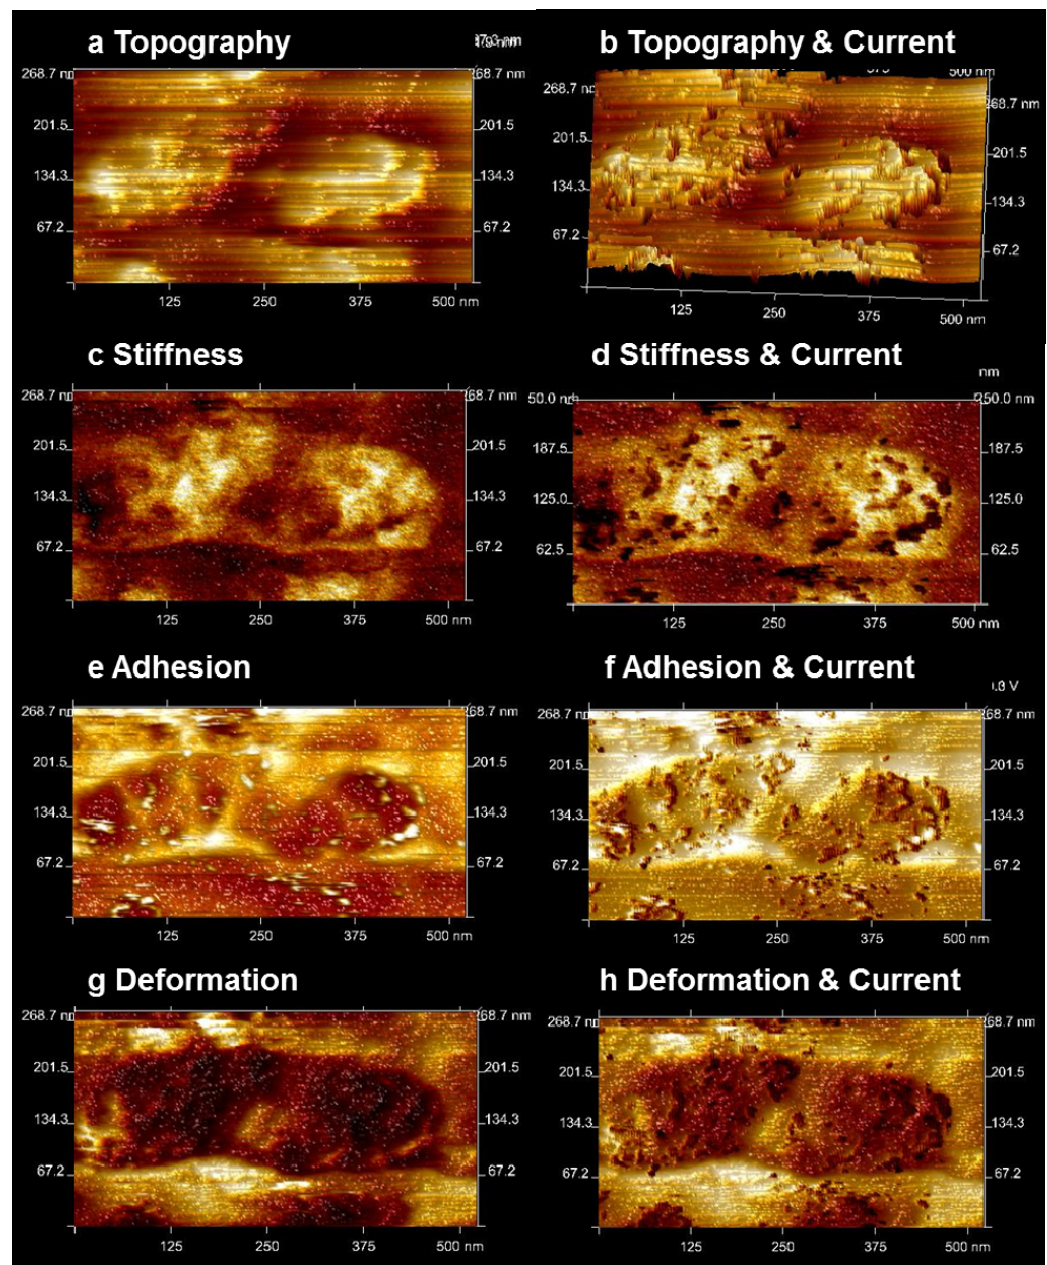
Figure 9. Zoomed area of Figure 6 of activated Nafion ® 112 under current flow. ( a ) Topography image of two swollen areas. ( b ) Overlay of topography and current images; current flow is restricted to step edges. ( c ) Conductive swollen areas have high stiffness. ( d ) Overlay of stiffness image with current; decrease of stiffness at site of current spots. ( e ) Decreased adhesion at swollen area with high adhesion at small spots. ( f ) Overlay of adhesion image with current; high adhesion spots coincide with larger current spots and indicate the formation of water droplets. ( g ) Deformation is decreased at the swollen area. ( h ) Overlay of the deformation with the current image; deformation is mostly reduced at the positions of water